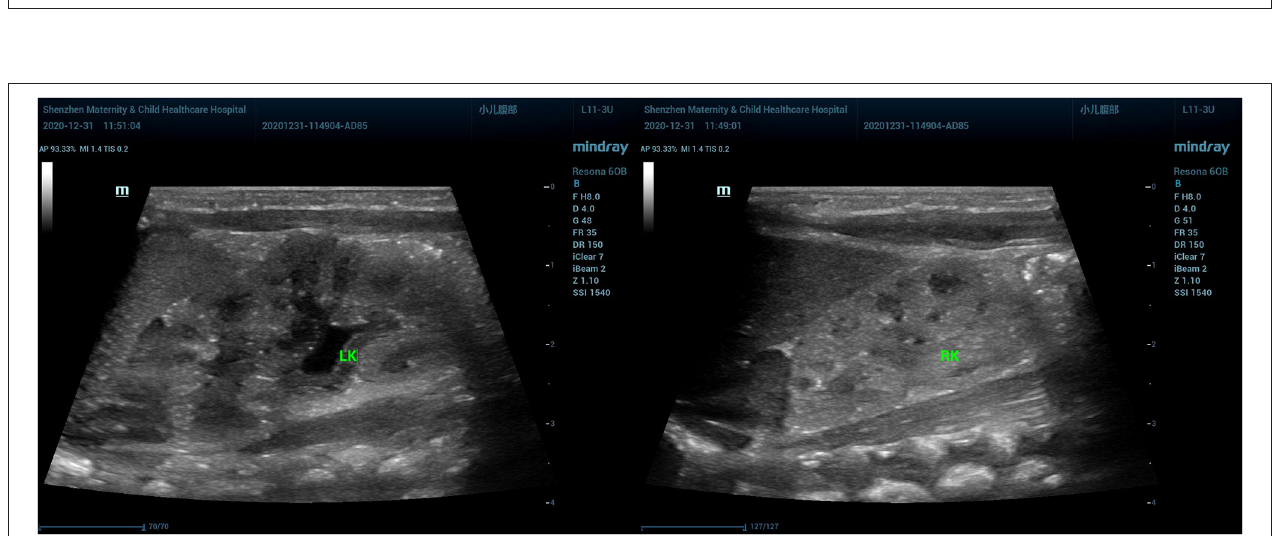
FIGURE 2 | The kidney ultrasound of the male neonate. Normal kidneys and adrenal glands are shown.